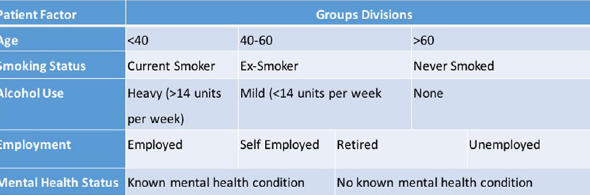
Table 1. Divisions within each patient factor